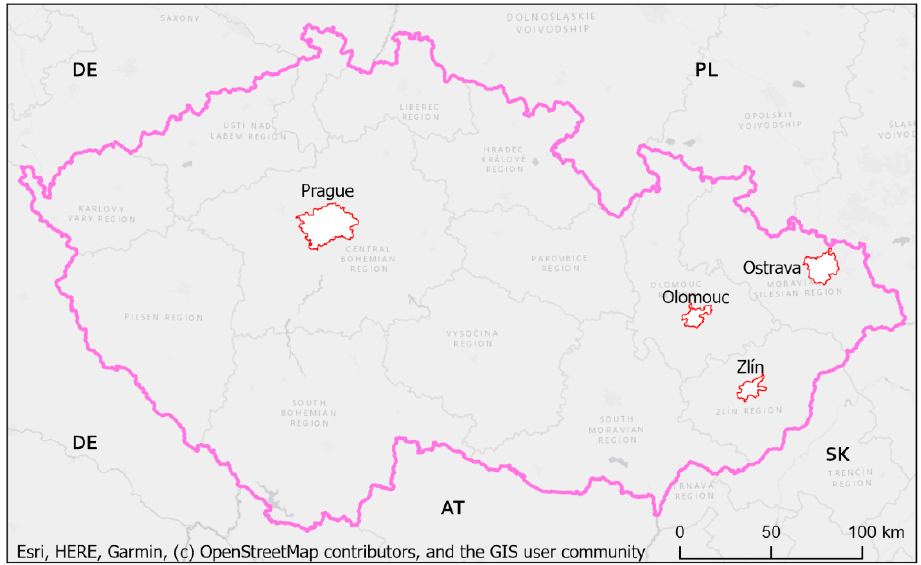
Figure 1. Study area—four selected cities within Czechia.